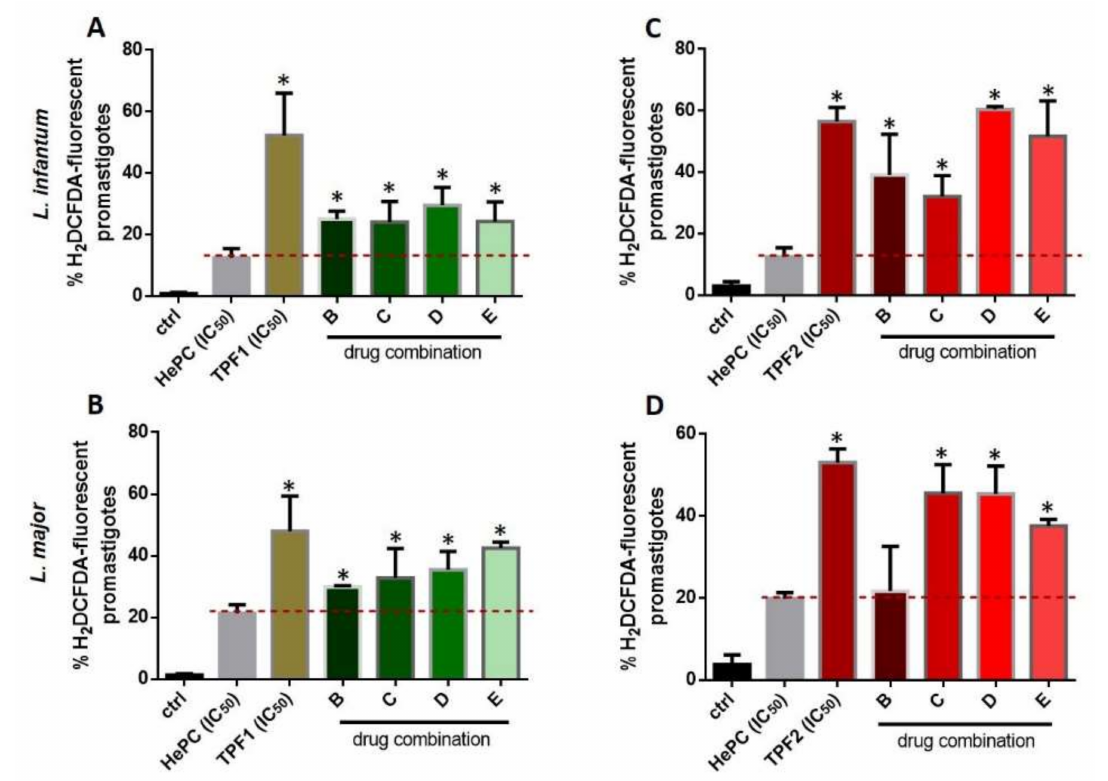
Figure 10. Intracellular ROS levels in L. infantum and L. major promastigotes treated with combinations of TPF1 and TPF2 with HePC. Log-phase promastigotes were treated with proportions of 4:1, 3:2, 2:3, and 1:4 of HePC and TPF1 ( A , B ) or TPF2 ( C , D ), respectively, for 72 h. Untreated parasites were used as a negative control group. ROS levels were quantified using H 2 DCFDA and flow cytometry. Data are presented as mean values of H 2 DCFDA-fluorescent promastigotes ( ± SD) in bar diagrams. The symbol of * indicates significant differences compared to HePC-treated